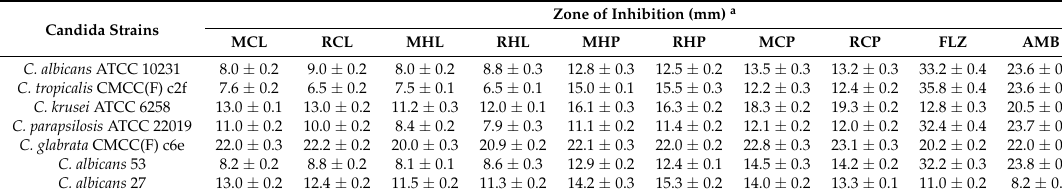
Table 4. Antifungal activity of Clausena lansium EOs (x ±